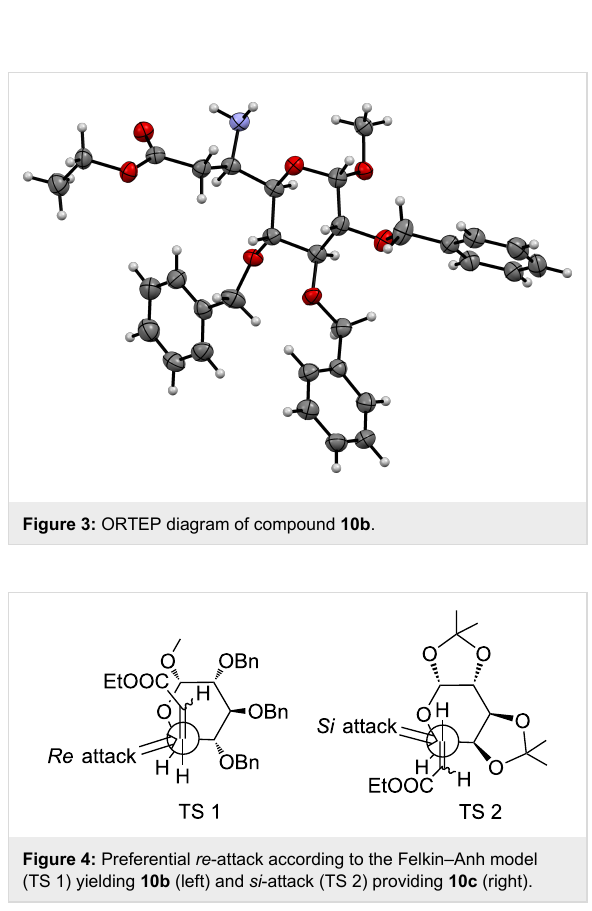
diastereomer in 91% yield that was identified by spectral data identical to the reported [57]. Formation of compound 10c is in accordance with the Felkin–Anh model. In case of compound 9c, the TS 2 (Figure 4) is favourable with the attack of ammonia to the C=C double bond from the si -face affording compound 10c as the only